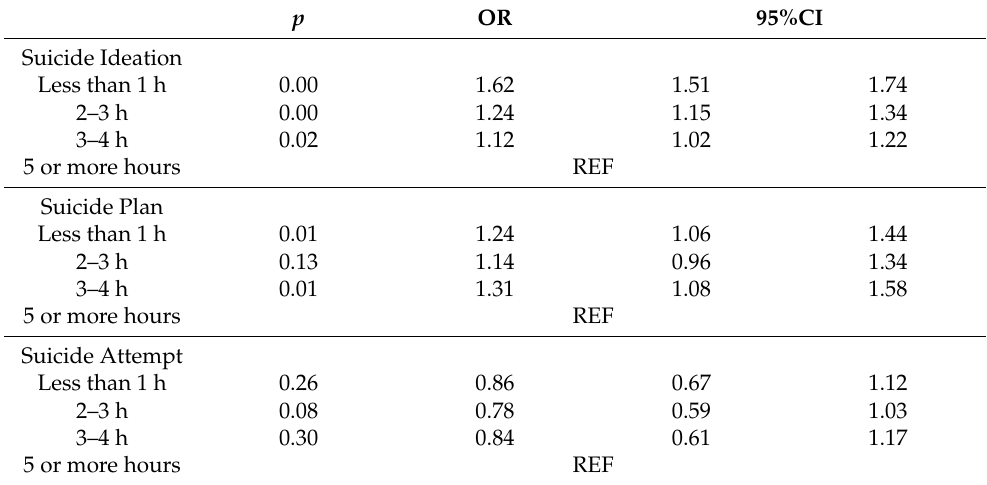
Table 2. Association between exercise with suicide ideation and plan in the overall sample. p